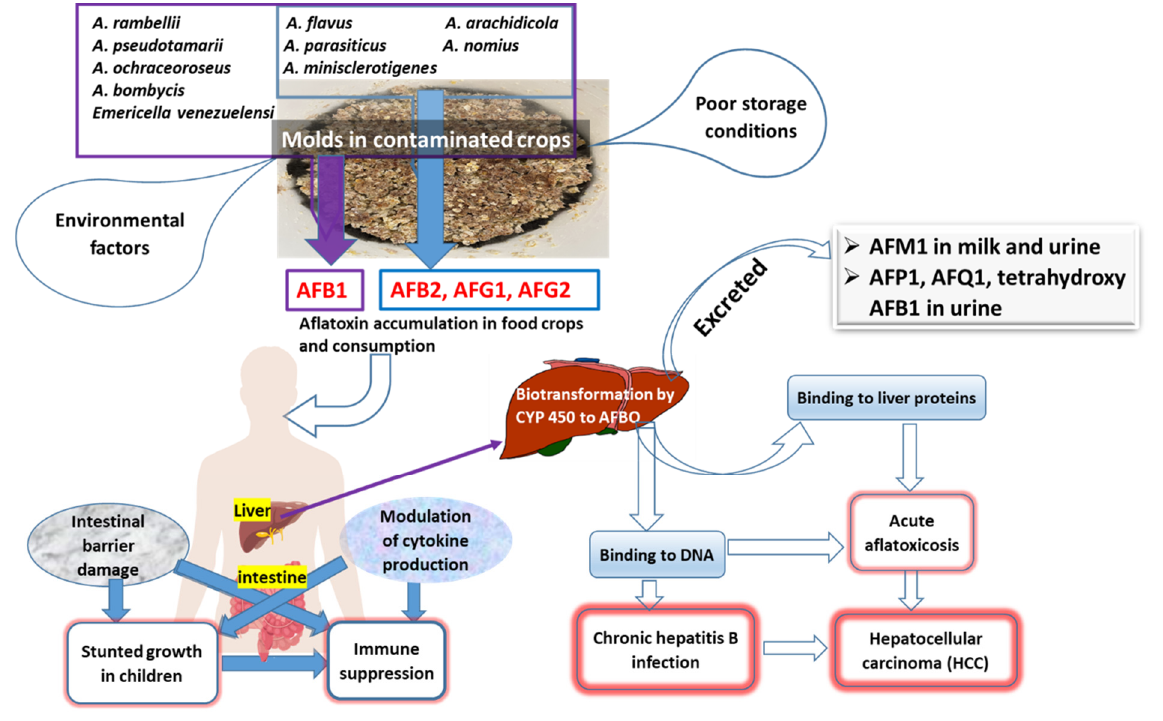
Figure 3. Sources, exposure, and pathogenesis pathway of aflatoxins ( A. : Aspergillus ). Among all types of aflatoxins, AFB1 is the most pathogenic and potent one, with its median lethal dose (LD 50 ) ranging from 1 to 50 mg/kg for most species and less than 1 mg/kg for highly susceptible animals like poultry, rainbow trout, and rats, with the sus- ceptibility of a given species also varying according to genetic background, age, nutri- tional factors, and detoxification ability of its liver [23,76].